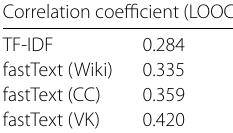
Figure 2 The predictive power of the model depending on the number of posts used per user. First, users with at least 20 posts were selected. Then, for each user, N of their posts were selected to predict their academic performance ( N = 1, ... ,20). The shaded region corresponds to the bootstrapped